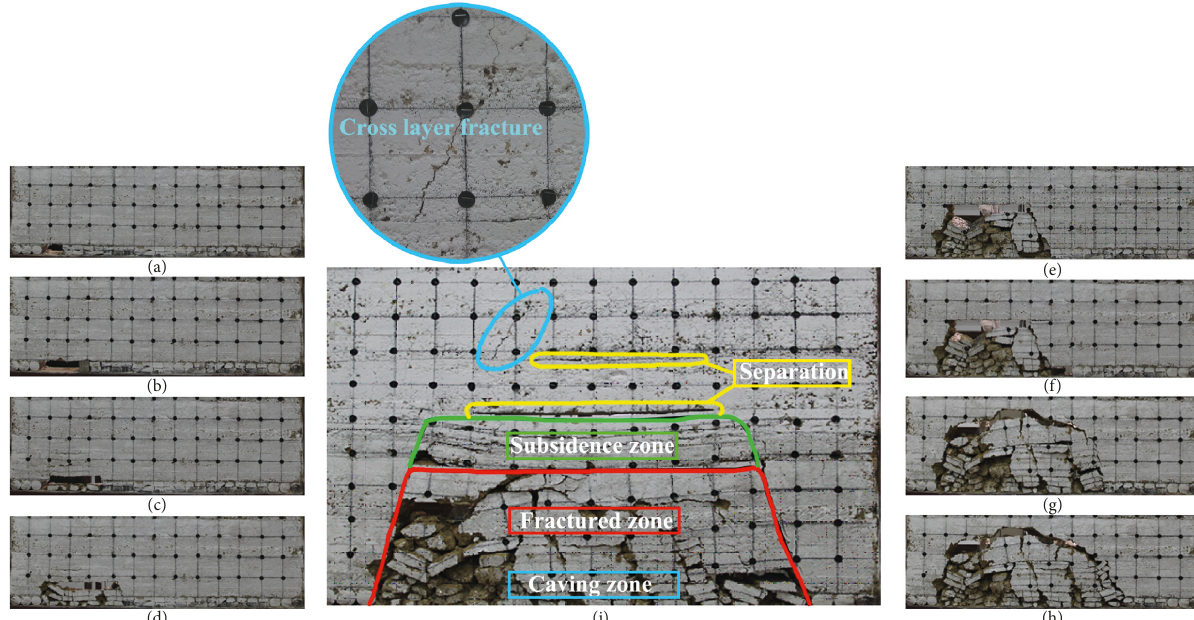
Figure 8: Failure process diagram of the overlying strata. Face advancing (a) 20m, (b) 40m, (c) 60m, (d) 80m, (e) 100m, (f) 120m, (g) 140m, (h) 160m, and (i) 220m. Table 6: On-site borehole survey data of working face. Drilling